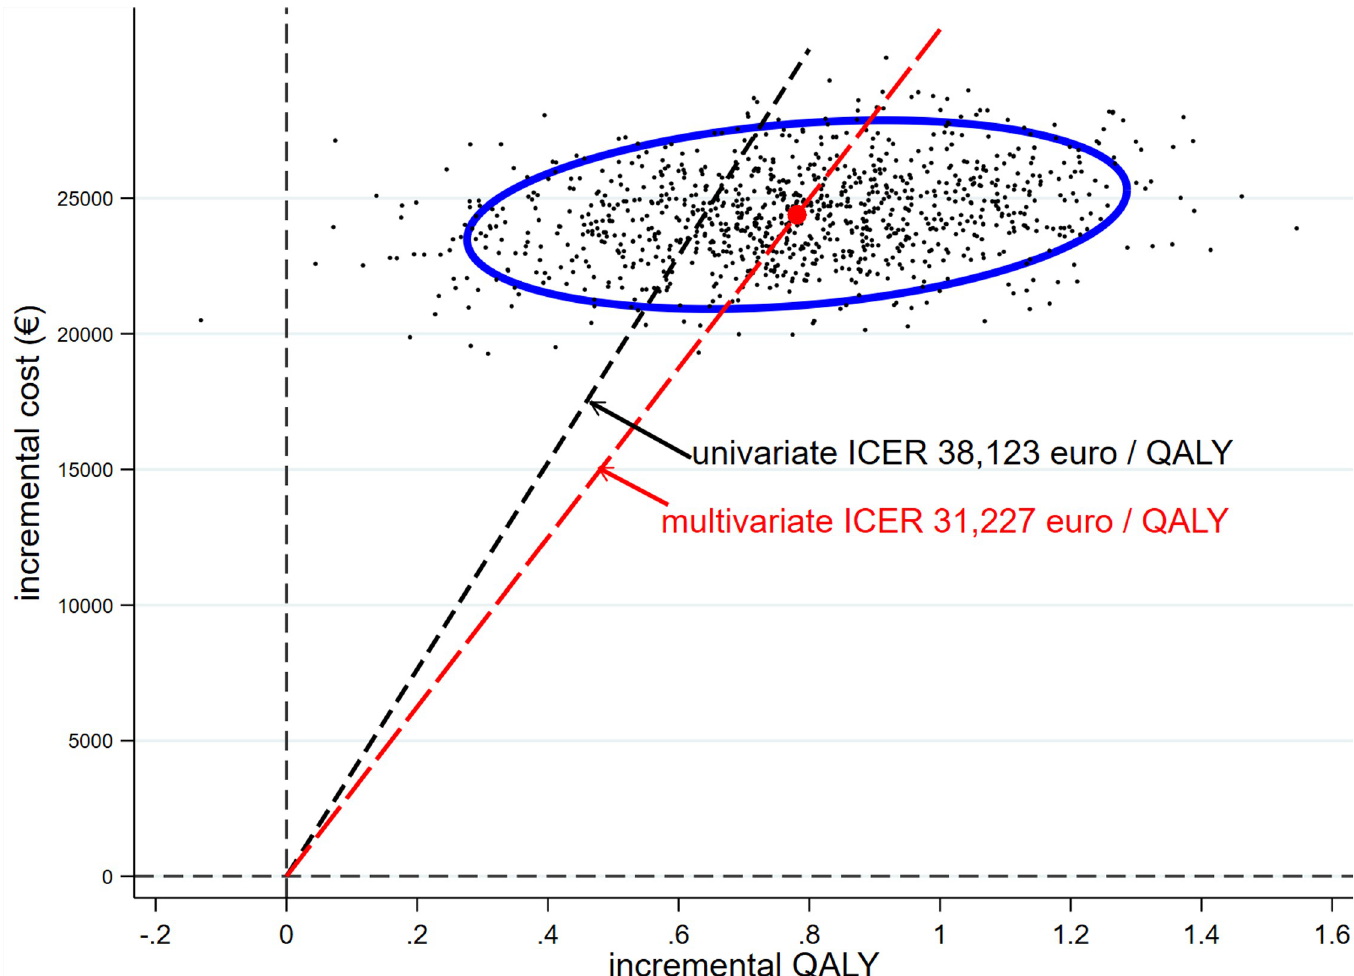
Fig 6. Univariate (black dashed line) and multivariate (red dashed line) results plotted on the cost-effectiveness plane. The black dots represent bootstrapped estimates, the blue elipse represents 95% CI around the mean multivariate bootstrap estimate.